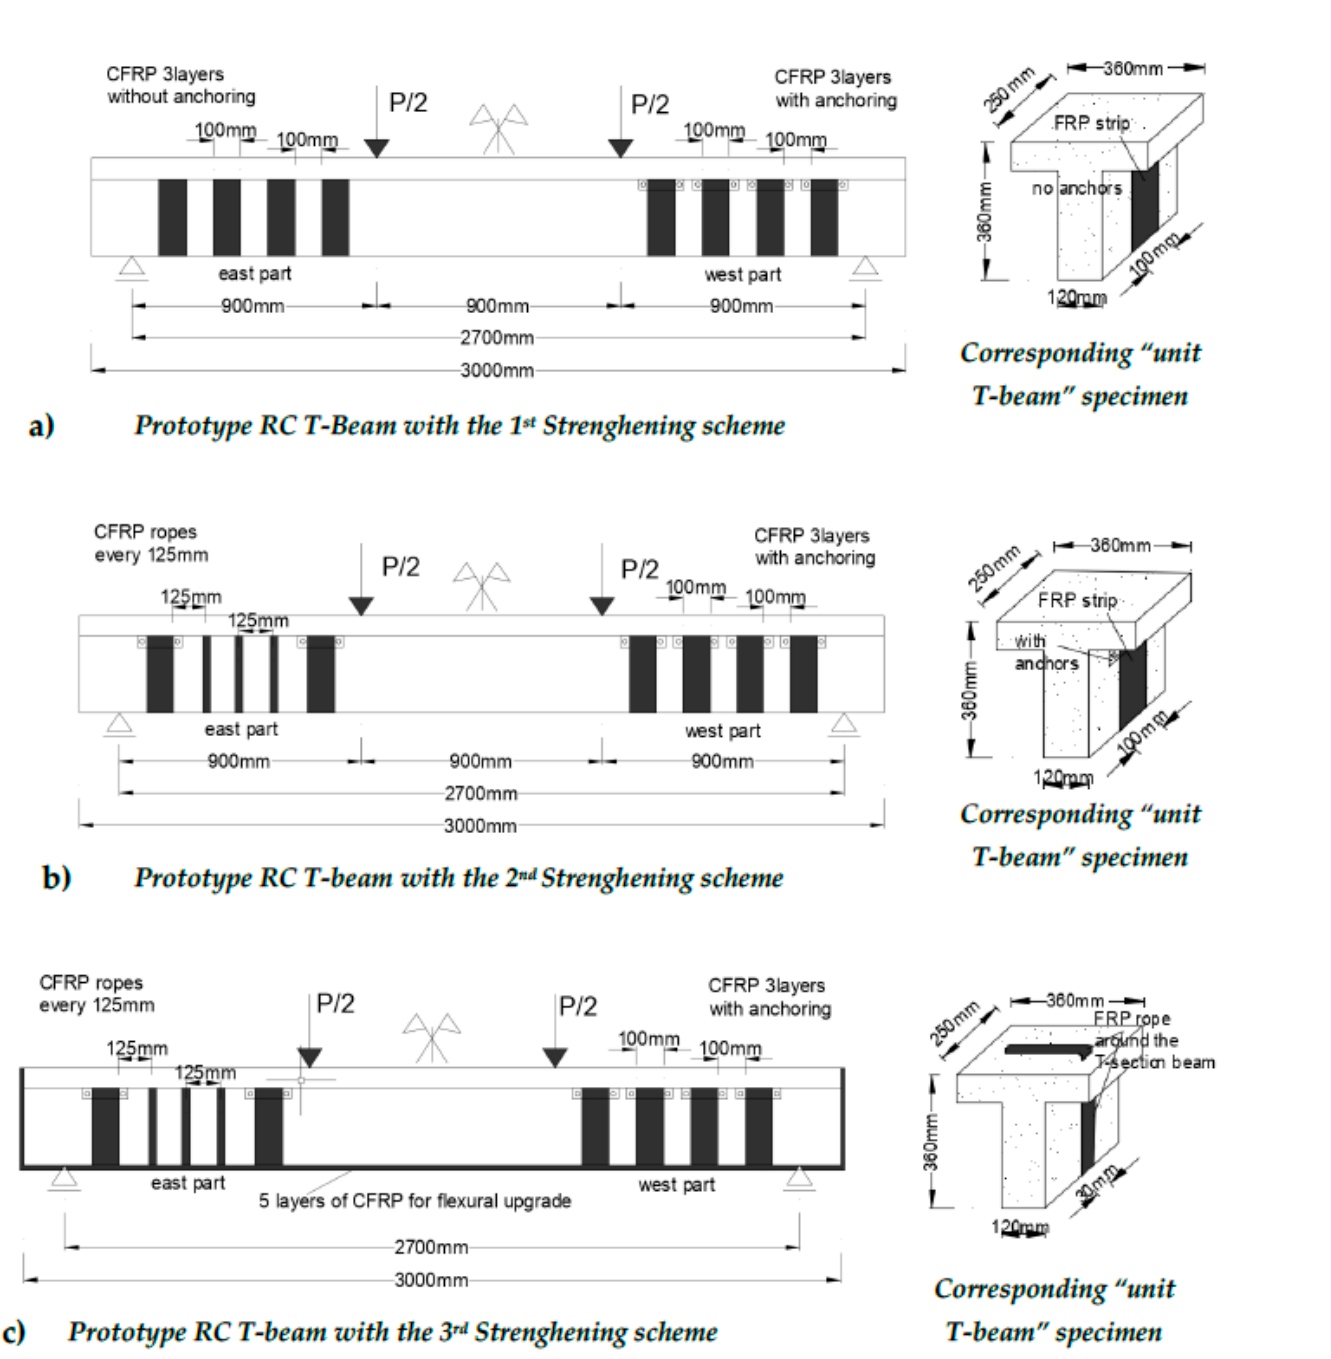
Figure 10. ( a ) 1st strengthening scheme of R/C T-beam (see also Figures 8b and 9a). ( b ) 2nd strengthening scheme of R/C T-beam (see also Figures 8c and 9b). ( c ) 3rd strengthening scheme of R/C T-beam (see also Figures 8d and